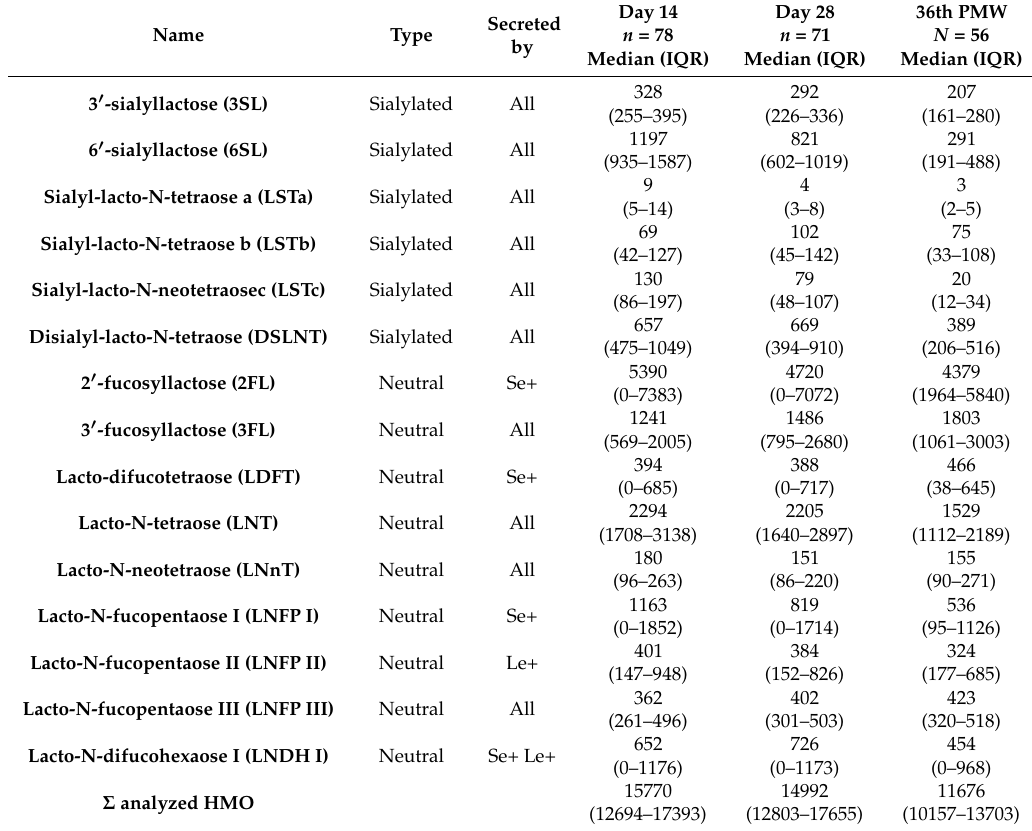
Table 1. Median human milk oligosaccharides (HMO) levels ( µ mol/L) in breast milk from mothers to extremely low birth weight (ELBW) infants during the neonatal